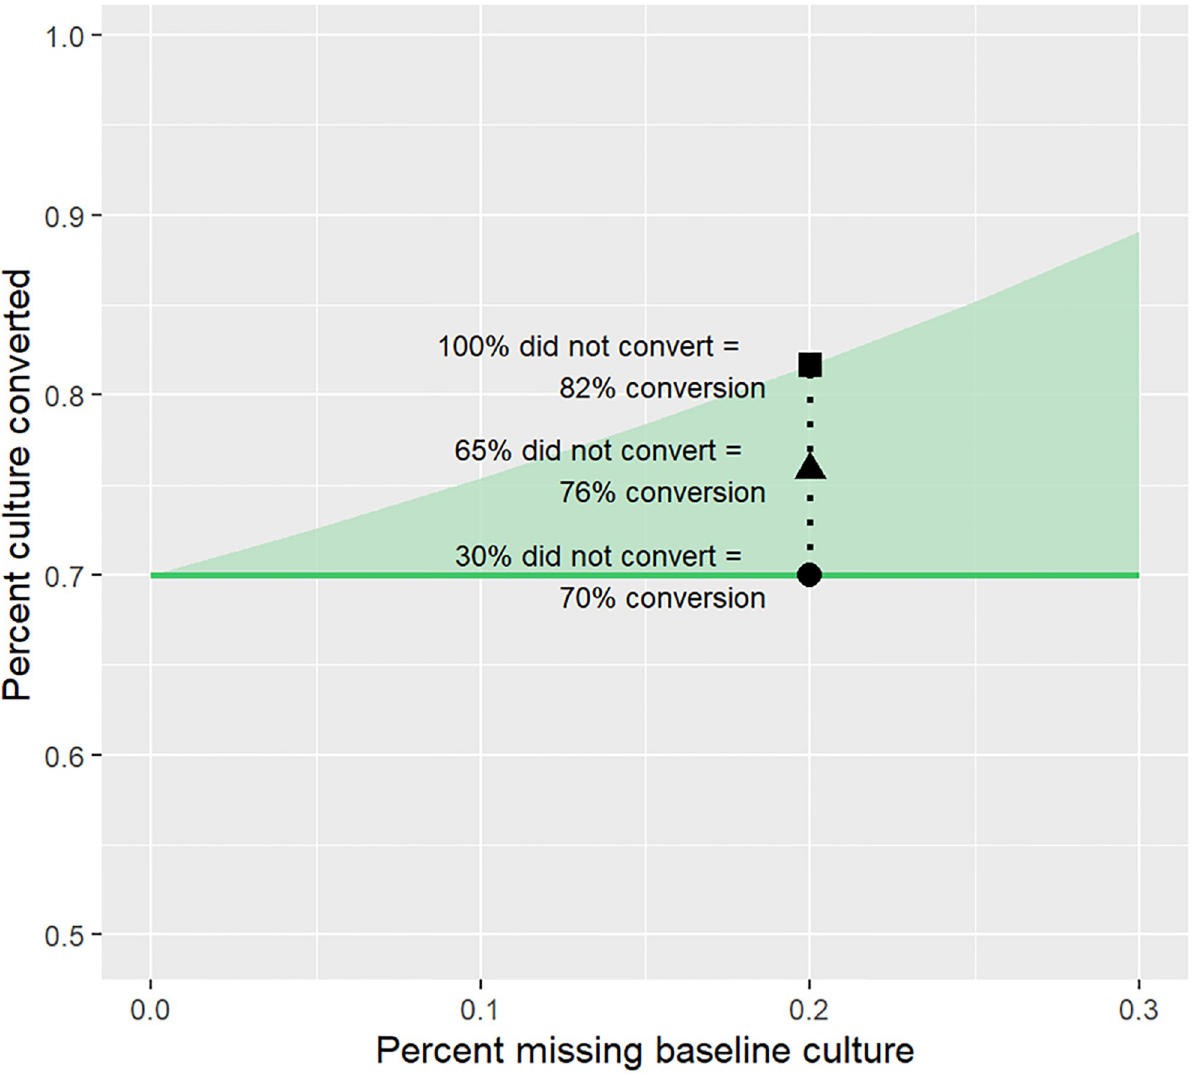
Fig 1. Culture conversion among participants missing a pre-treatment culture, simulation study of cohort where P t = 70%, P t │ m = 50%, and C │ P t = 70%. Fig 1 represents a simulated cohort of patients in which: 1) 70% are truly culture positive, 2) Of patients missing a culture 50% are truly culture positive and 50% are truly culture negative patients, and 3) among truly culture-positive patients, 70% achieved culture conversion. If 20% (x- axis = 0.20) of patients were missing their pre-treatment culture and 100% of these patients did not convert (e.g., due to early death or LTFU during the post-treatment interval), the observed proportion with culture conversion would be 82% ( & ), a 12 percentage point discrepancy. If 65% (i.e. the halfway point of the shaded region) did not convert, the observed proportion would be 76% ( ▲ ), a 6 percentage point discrepancy. If 30% did not convert (i.e. the point at which conversion frequencies in patients missing a baseline culture and patients observed to have a baseline culture are equal), the observed proportion would be 70% ( ● ), no discrepancy. The shaded region can be interpreted similarly in Figs 2–4. Abbreviations: Culture positive truth (P t ); Culture positive truth │ Culture missing observed (P t │ m); Converted │ Culture positive truth (C │ P t ).